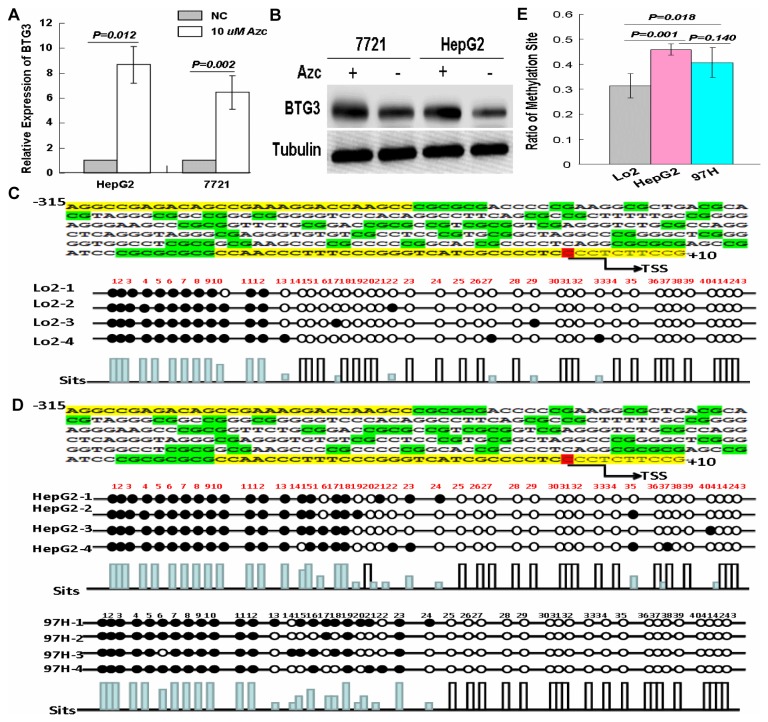
Promoter hypermethylation contributes to the transcriptional silencing of BTG3 in HCC.(A) Real-time PCR analysis of BTG3 expression after 5Aza-C treatment in HepG2 and 7721 cells. The relative mRNA levels with the use of control cells without 5Aza-C treatment were normalized to 1. (B) Western blotting analysis of BTG3 expression in HepG2 and 7721 cells after 5Aza-C treatment. Tubulin was shown as a control. (C) DNA sequencing results of methylation sites in LO2 cells. (D) DNA sequencing results of methylation sites in HepG2 and 97H cells. (E) Ratio of methylation sites of HepG2 or 97H cells was compared with that of LO2 cells.